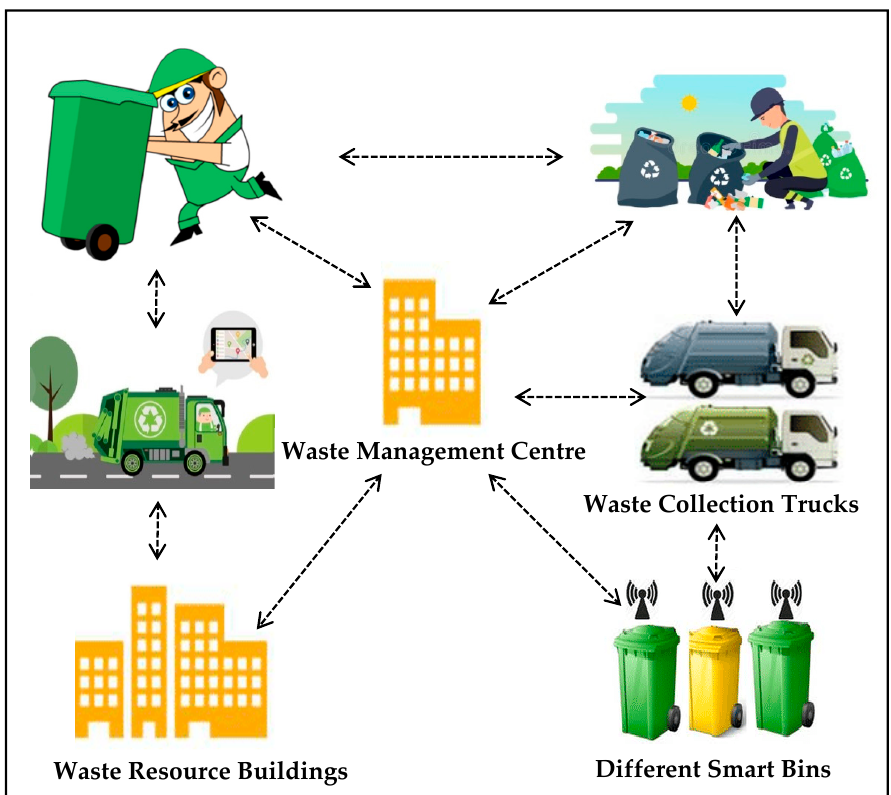
Figure 6. Waste management system architecture.